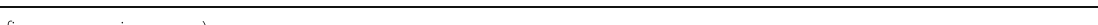
(See figure on previous page.) Fig. 5 ASH-WEX and FIV protect neurons from LPS activated microglial mediated neurotoxicity ( a , b , c ) Representative Confocal micrographs of MAP2 immunostaining of primary hippocampal, cortical and cerebellar neurons, respectively treated with (column I) ASH-WEX and FIV with or without activation with 100 ng/mL LPS and (column II) LPS conditioned medium collected from LPS stimulated primary microglial cells with or without pretreatment with ASH-WEX and FIV for 24 h. ( d , e , f ) Histograms presenting relative optical intensity of MAP2 (Mean ± SEM) in primary hippocampal, cortical and cerebellar neurons, respectively,among different treatment groups. ( g , h , i ) Histograms depicting percentage neurite outgrowth (Mean ± SEM) in primary hippocampal, cortical and cerebellar neurons, respectively, among different treatment groups calculated from three independent experiments. Cultures treated directly with ASH-WEX and FIV with or without activation with LPS were taken as 100%. Direct treatment of 100 ng/mL LPS was observed to be non-toxic for neurons. * p ≤ 0.05 CM-Control versus CM-ASH-WEX alone, CM-FIV alone, CM-LPS + ASH-WEX and CM-LPS + FIV-treated groups. + p ≤ 0.05 CM-Control versus CM-LPS-treated group. # p ≤ 0.05 CM-LPS- versus CM-LPS + ASH-WEX- and CM-LPS + FIV-treated groups. & p ≤ 0.05 represents statistically significant difference between cultures treated with or without microglial conditioned medium corresponding to different treatment groups (one way ANOVA with Holm-Sidak post hoc test). Images were captured